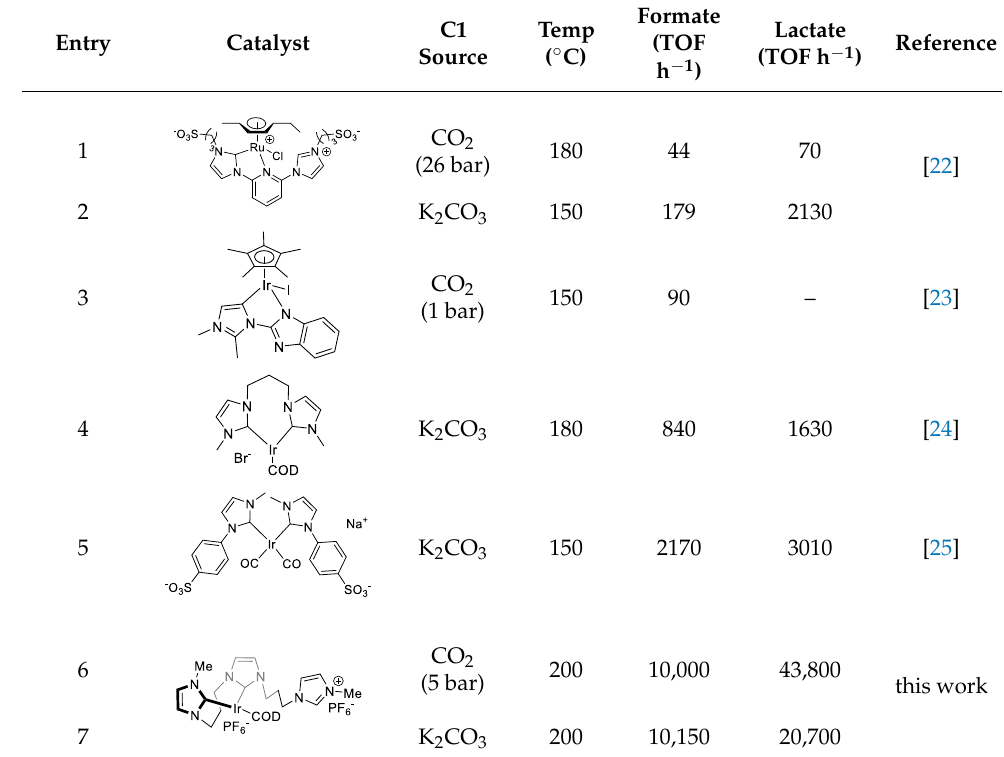
2 and inorganic car-